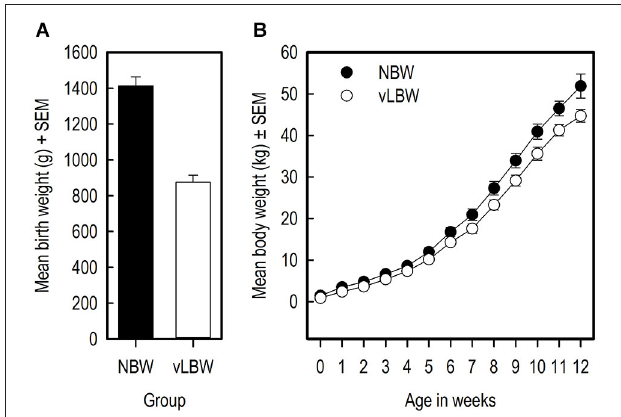
FIGURE 3 | Weights and growth of the piglets. (A) The birth weights of the vLBW and NBW piglets in grams. (B) The body weight of the piglets in kilograms over the course of the experiment.